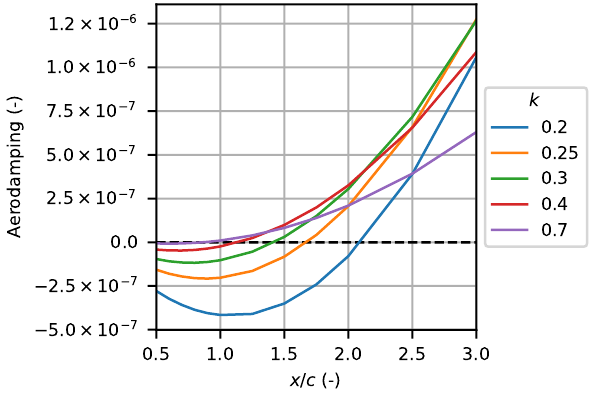
Figure 16. Effect of x / c on aerodamping at constant k—IBPA =